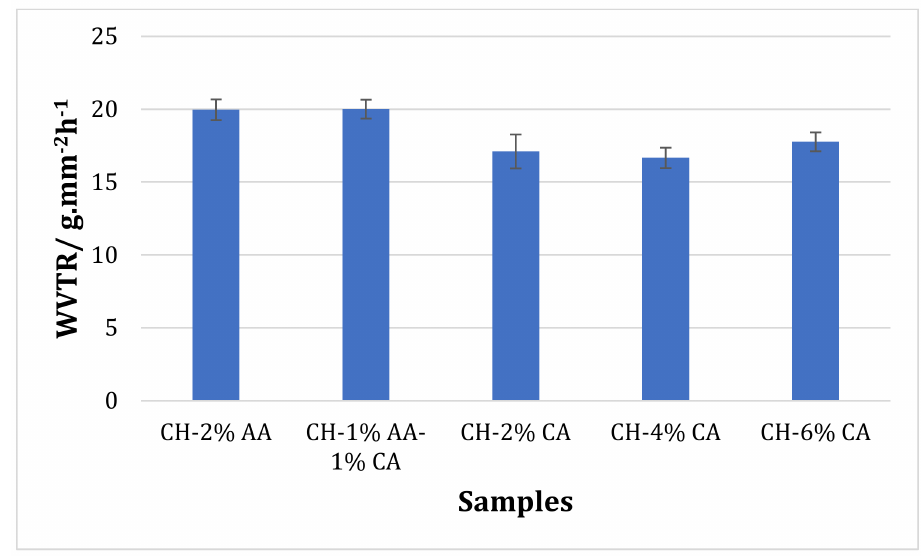
Figure 7. Water vapor transmission rate (WVTR) of chitosan films prepared using acetic acid (2% v / v ) and citric acid (2, 4, and 6% w / v